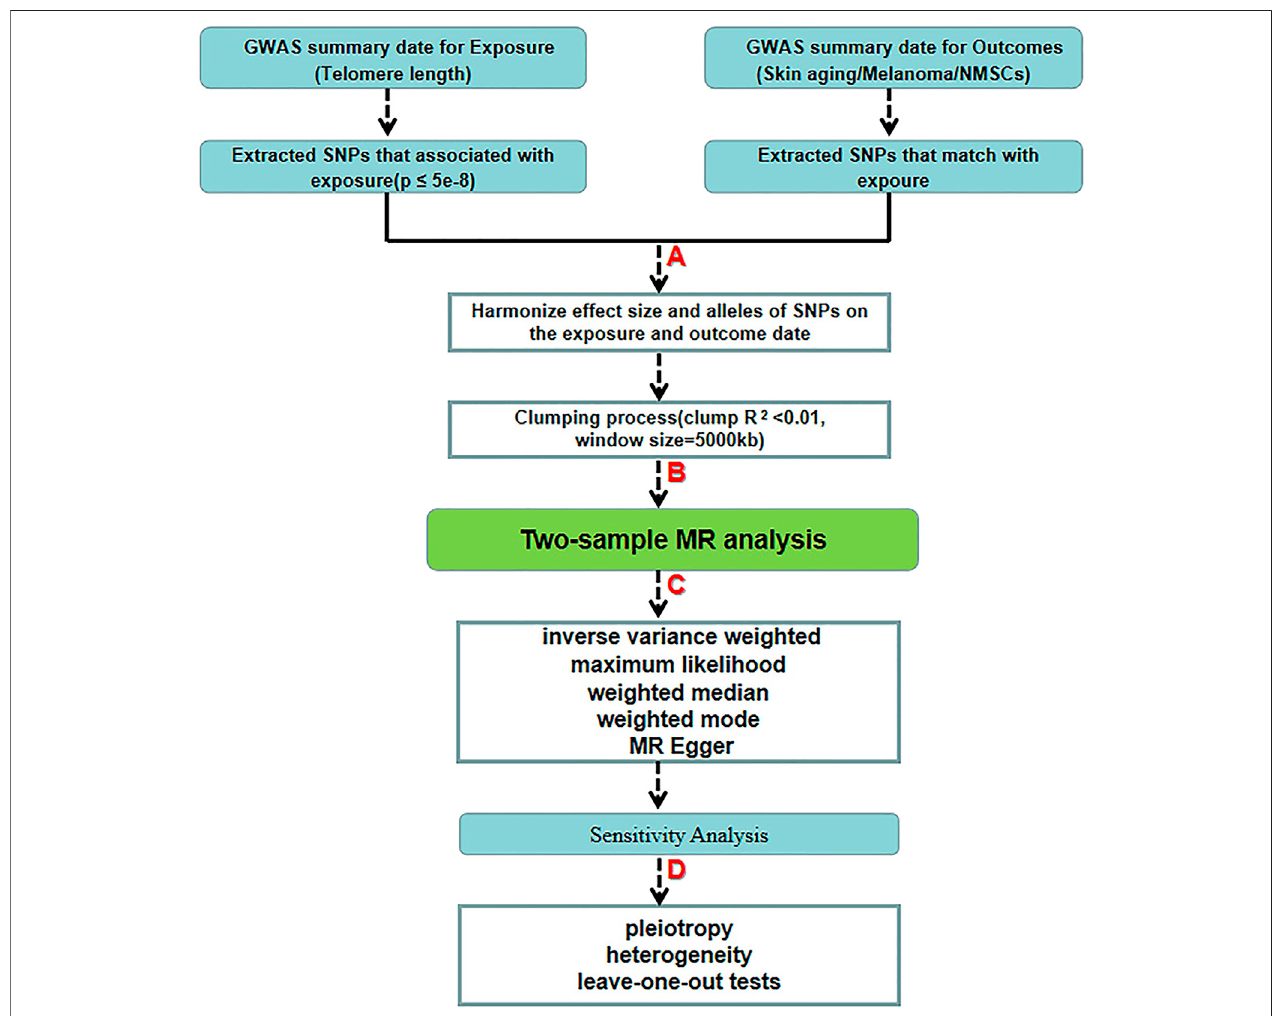
FIGURE2| Schematic diagram ofthetwo-sample-MR analysisprocess. (A) Screeningfrom GWAS data forselected SNPs signi fi cantlyassociatedwith exposure ( p < 5.00 E-08 at genome-wide threshold). (B) Obtaining independent SNPs and examining effect size outliers with linkage disequilibrium (LD) with r < 0.01 or physical distance greater than 5000 kb. (C) Two-sample MR analysis by fi ve algorithms. (D) Quality control by sensitivity analysis.